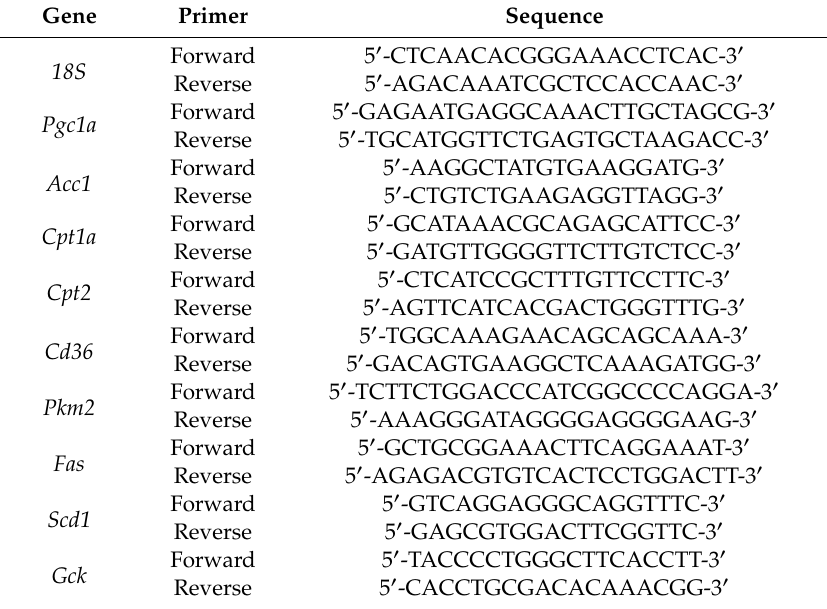
Table 3. Primer sequences used in this